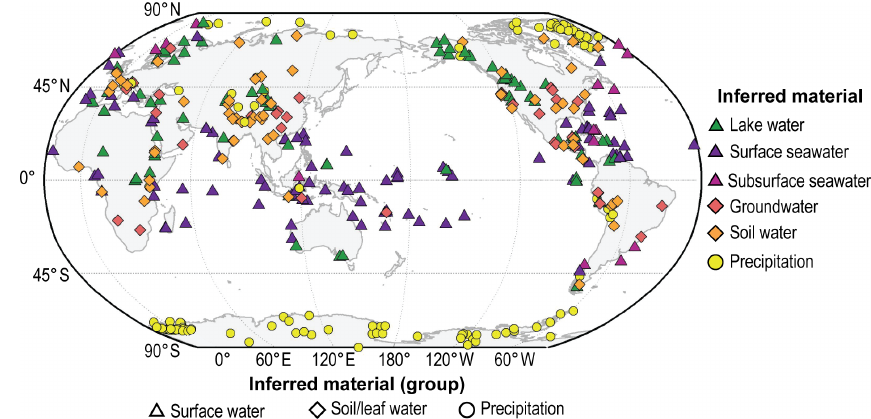
Figure 3. Map of records in the Iso2k database with colors representing the “inferred material” metadata field (Sect. 4.2) for each record (primary time series only; see Sect. 2.4). Symbols correspond to the inferred material super-groups.